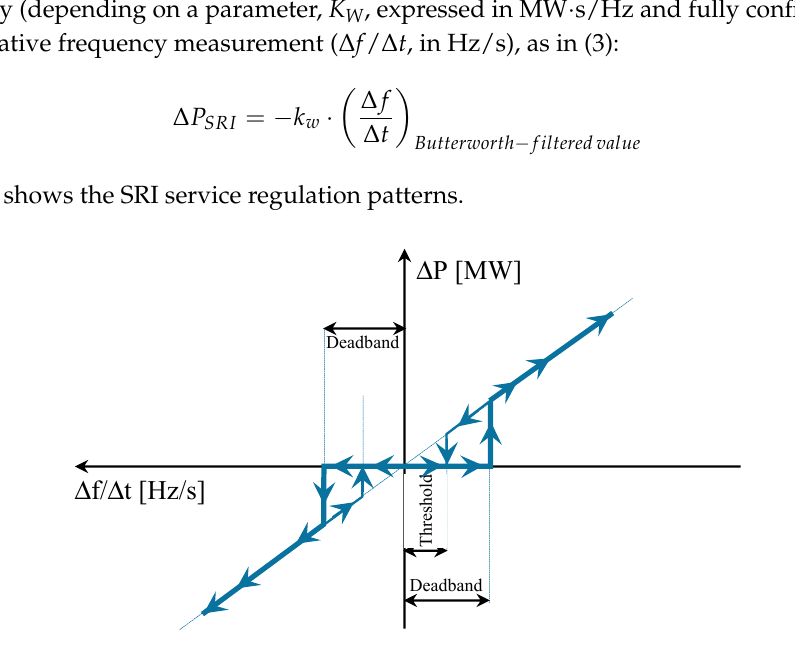
Figure 7. SRI ancillary service regulation patterns.